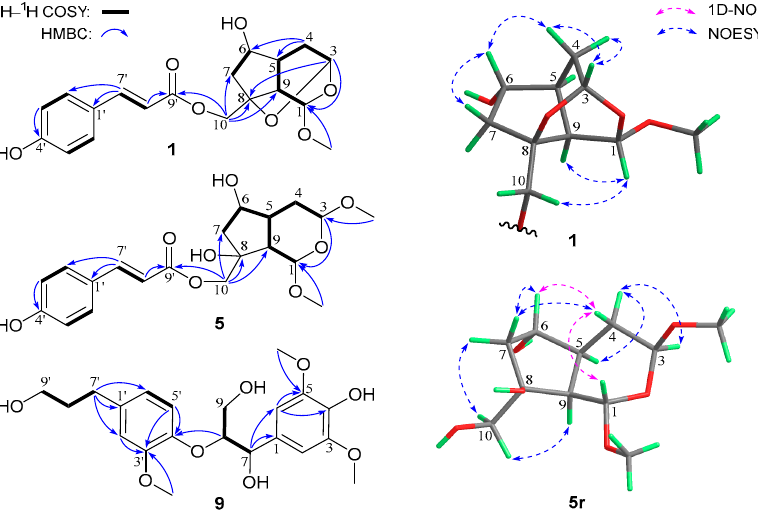
Figure 2. Key 2D NMR correlations for 1 , 5 , 5r, and 9 (for a better illustration, the enantiomers of 1 and 5r were used to show the NOE/NOESY signals). and 5r were used to show the NOE/NOESY